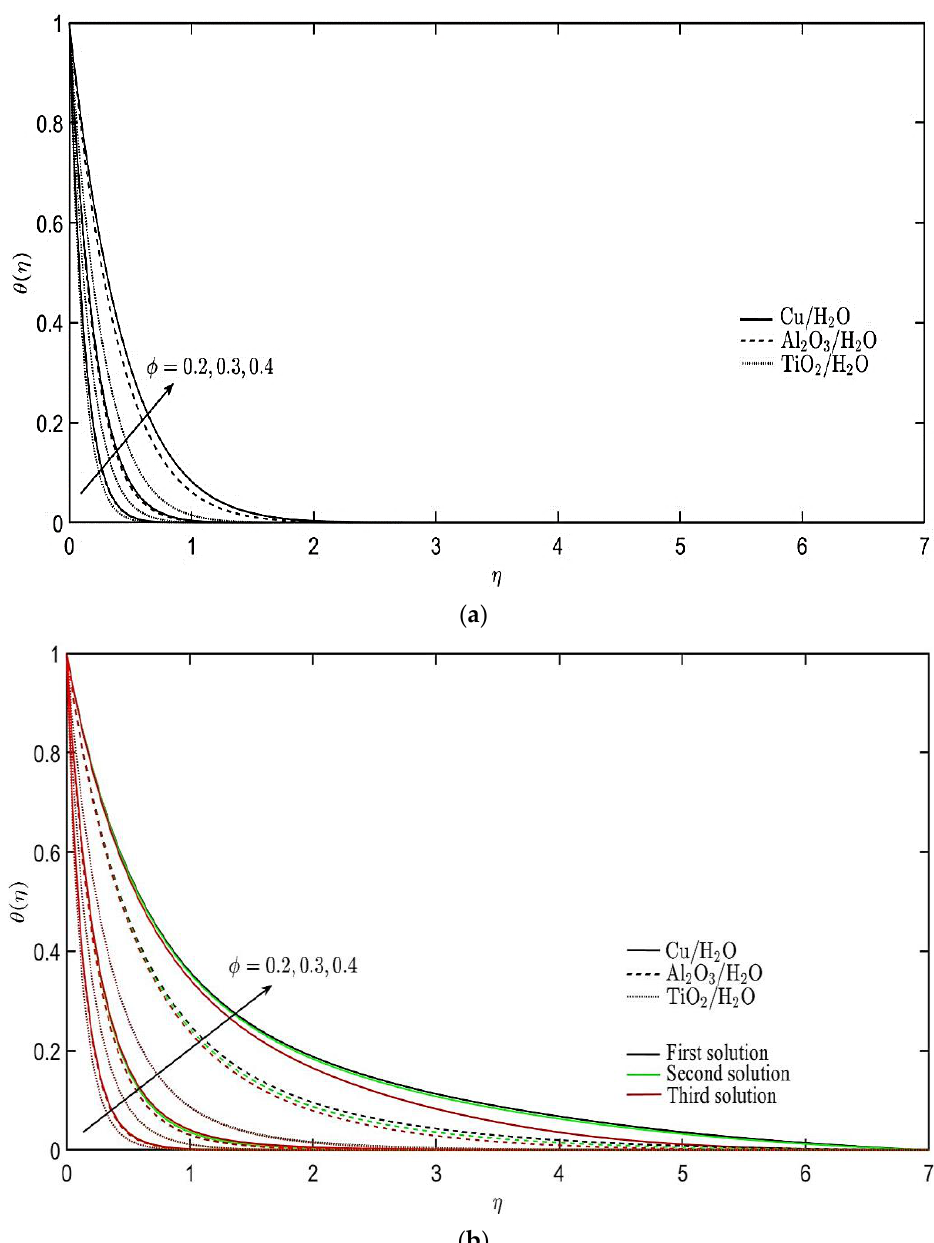
Figure 5. Effect of nanoparticle volume fraction on temperature profiles for: ( a ) Stretching case; ( b ) Shrinking case.